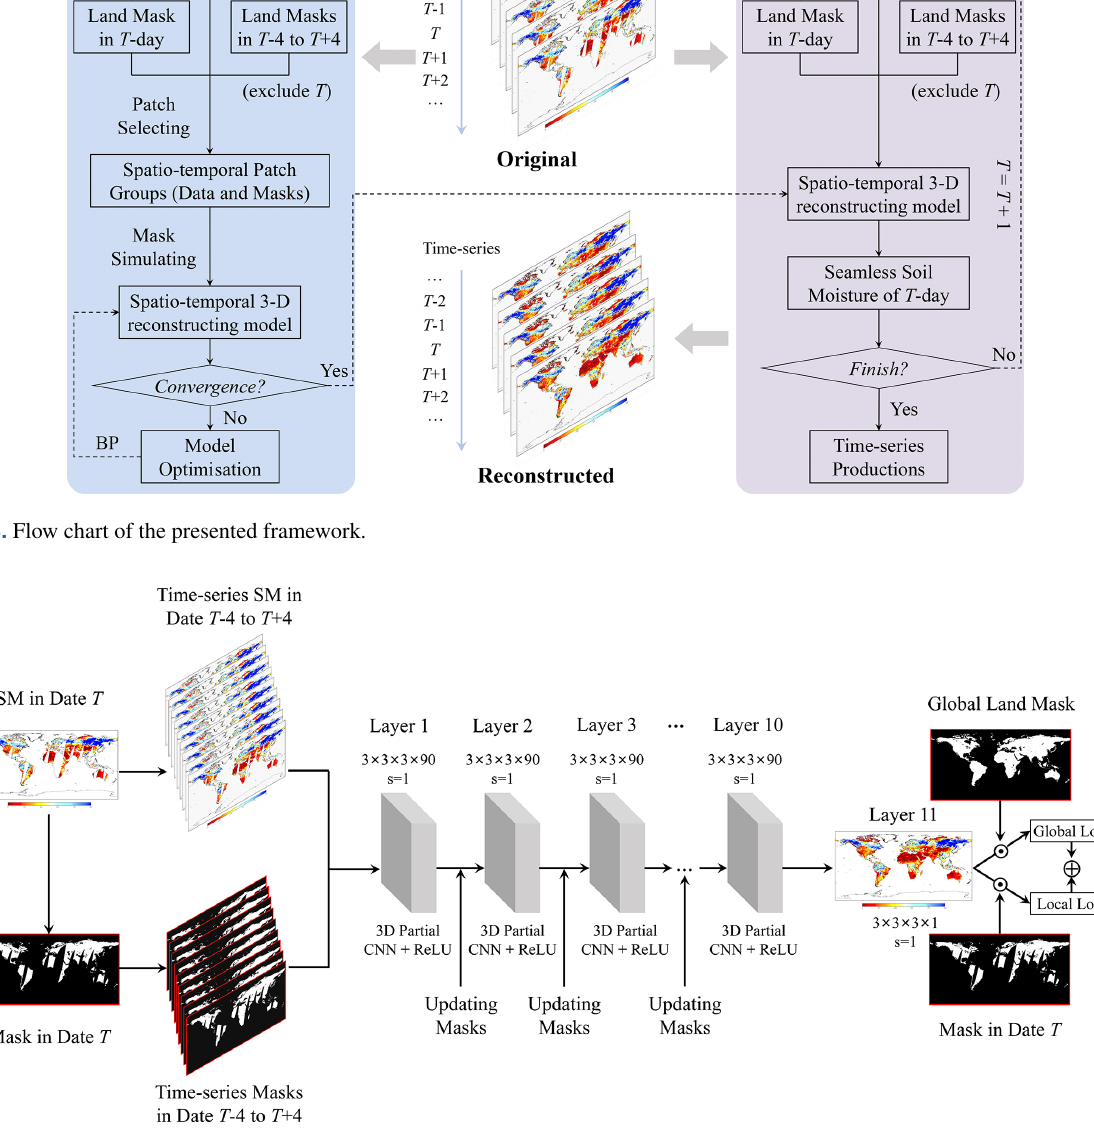
Figure 4. Spatio-temporal soil moisture 3D reconstruction